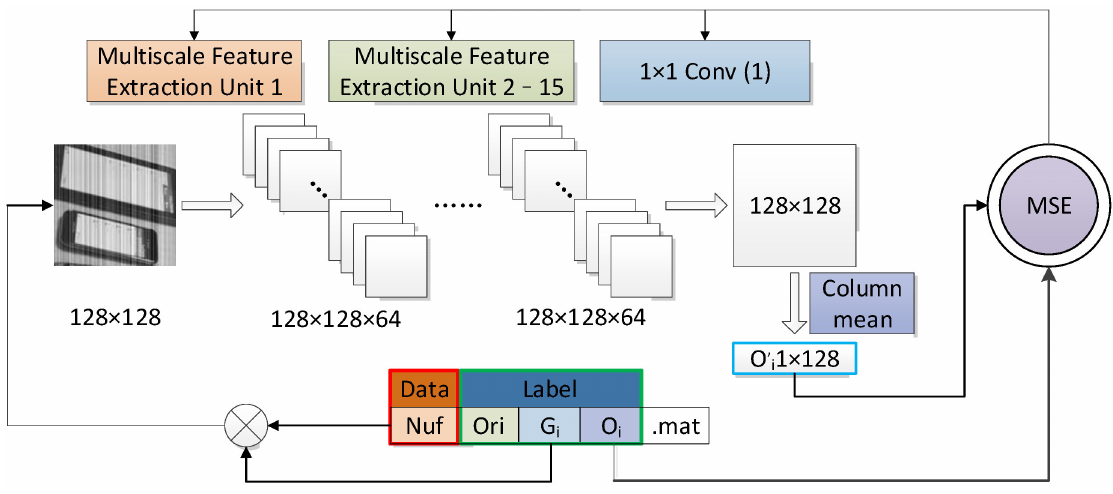
Figure 4. The offset correction sub-network